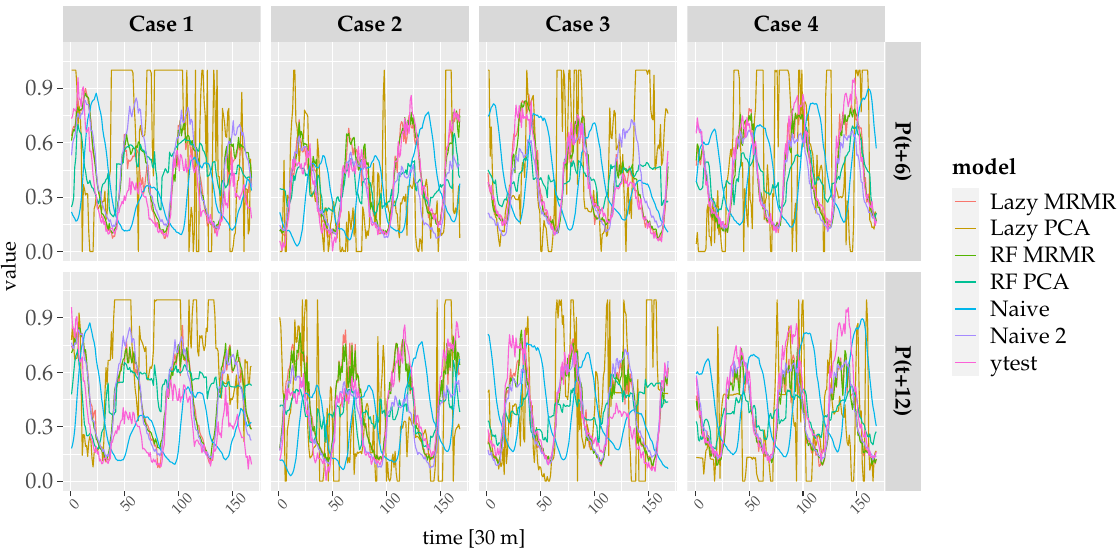
Figure 10. Visualization of actual ( ytest ) and predicted load trajectories for a 6 h forecasting